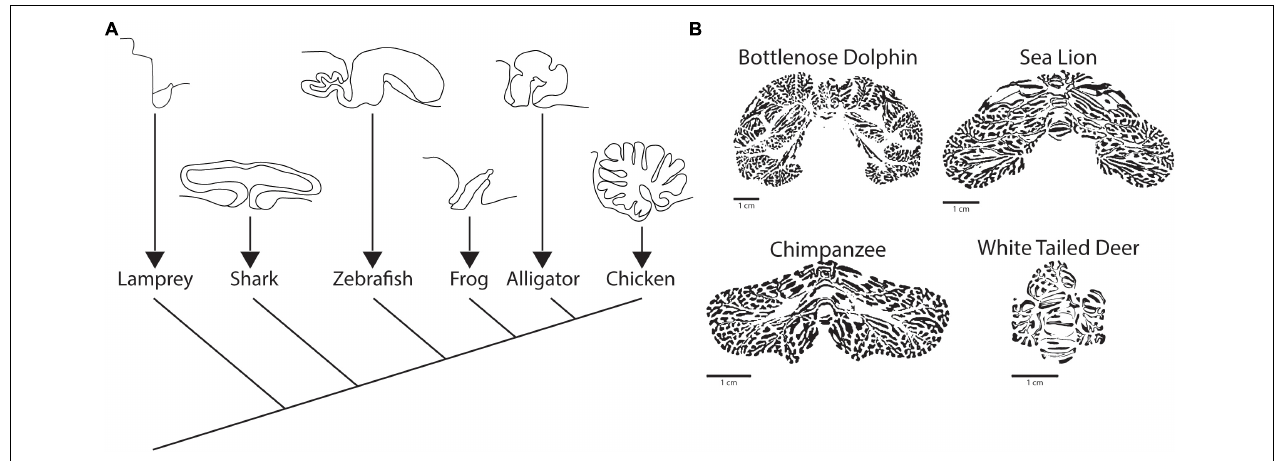
FIGURE 4 | Comparative evolution of the cerebellum. (A) Sagittal view of cerebellum and cerebellum-like structures across vertebrates, including a sagittal view of the octavolateralis of the lamprey. Adapted from Butts et al. (2011) with permission obtained from SpringerLink. (B) Examples of the posterior cerebella of three species (Bottlenose Dolphin, Sea Lion, Chimpanzee) that display vocal production learning and a single mammal (White Tailed Deer) that does not. Figure inspired by Smaers et al. (2018) but independently processed directly from Brainmuseum.org (Welker et al., 2019) use was as per open source published guidelines for both eLife and Brainmuseum.org,